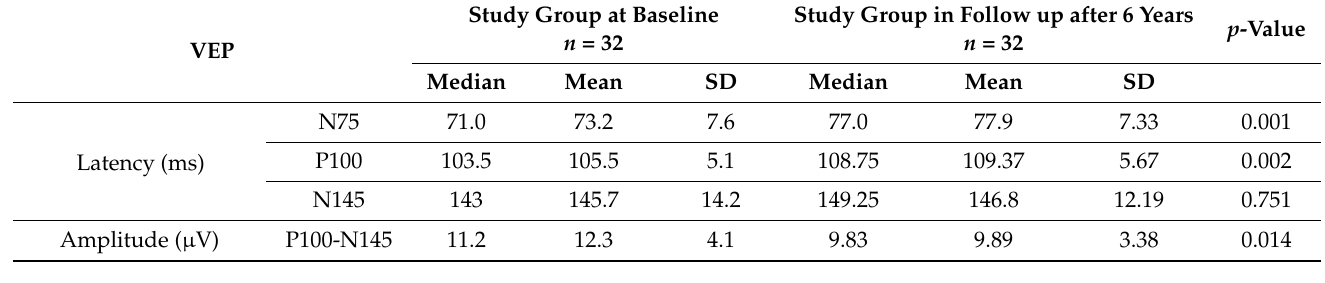
Table 4. Visual evoked potentials in the study group during baseline and in follow up after 6 years.